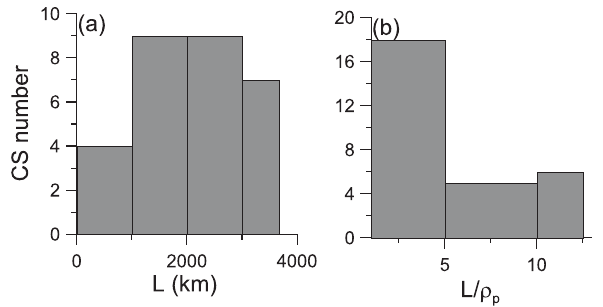
Fig. 7. The distribution of the thickness of strongly tilted CSs in absolute units (a) and in the units of proton thermal gyroradii (b) .